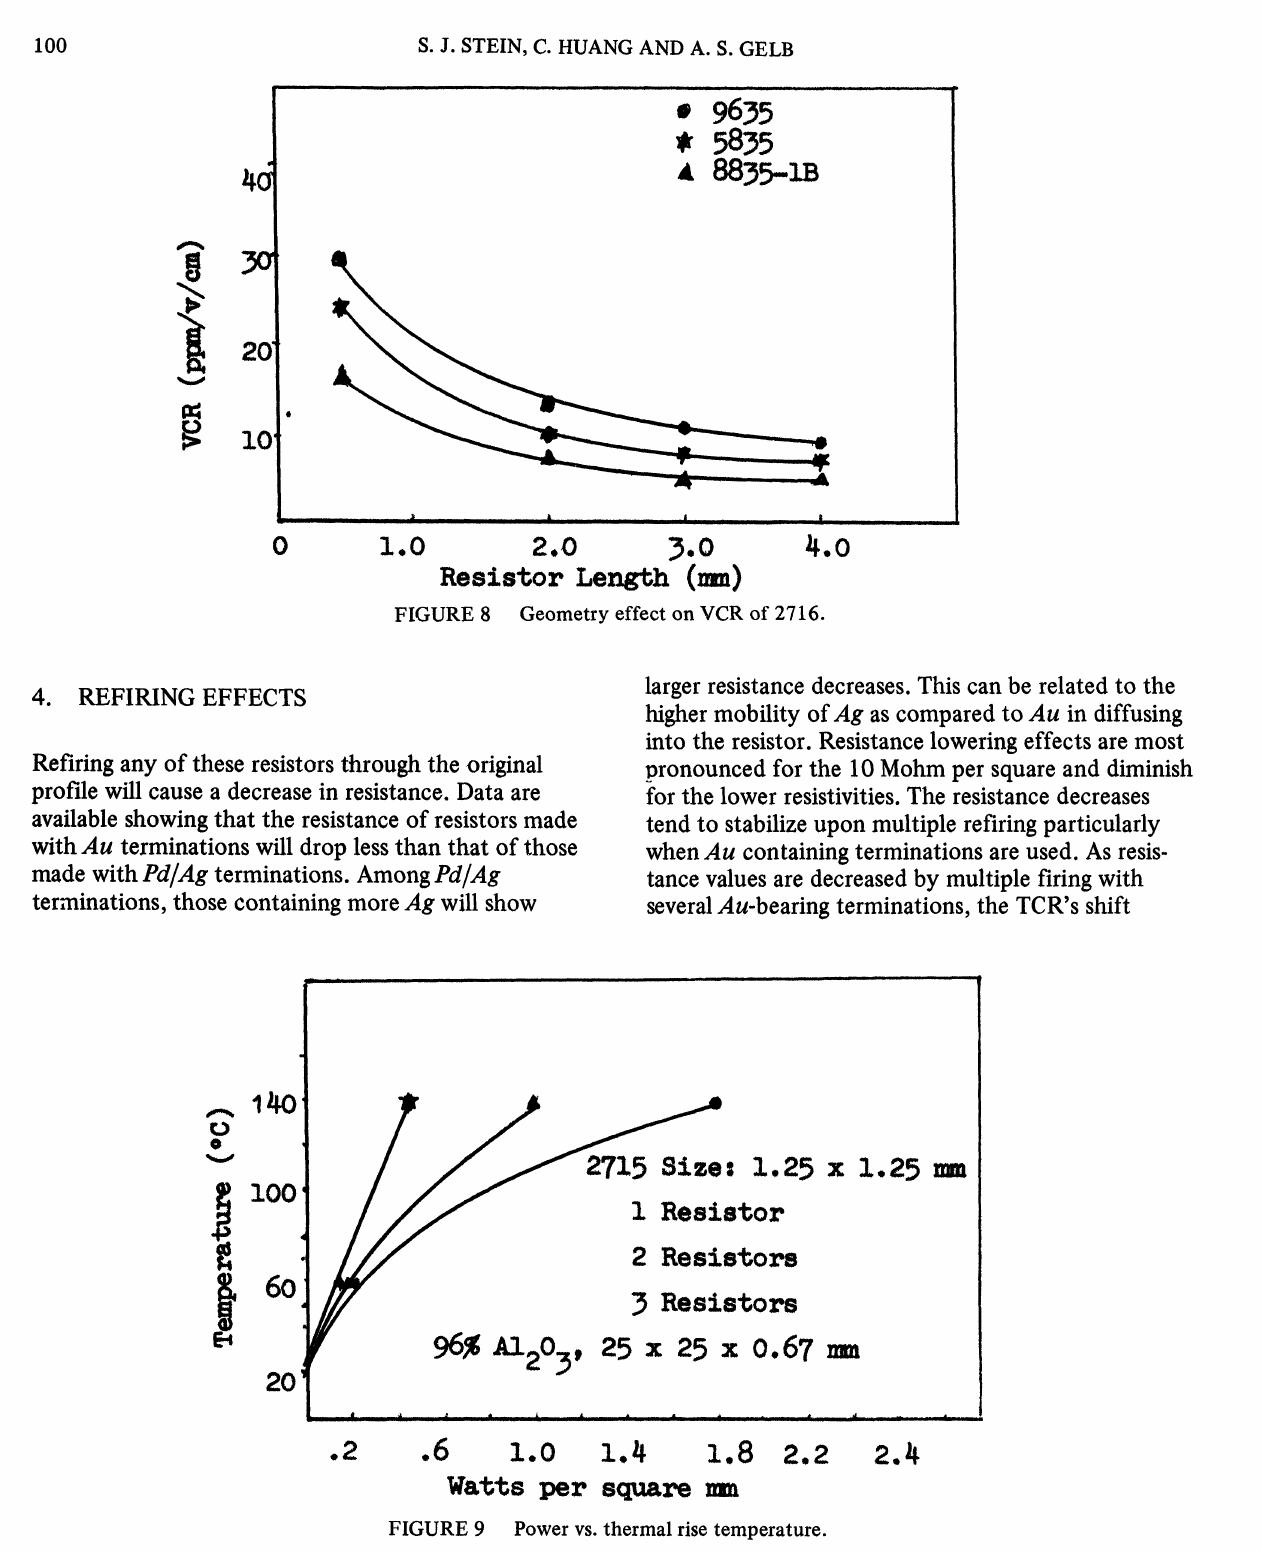
FIGURE 9 Power vs. thermal rise